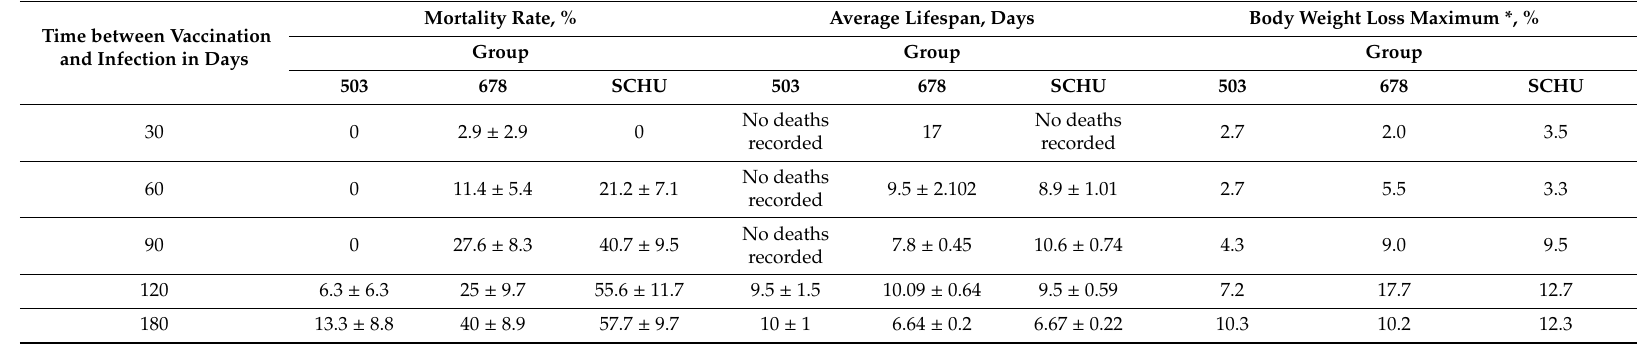
Table 2. Mortality, lifespan, and body weight loss of immunized mice infected with virulent F. tularensis strains at di ff erent times after immunization. Time between Vaccination and Infection in